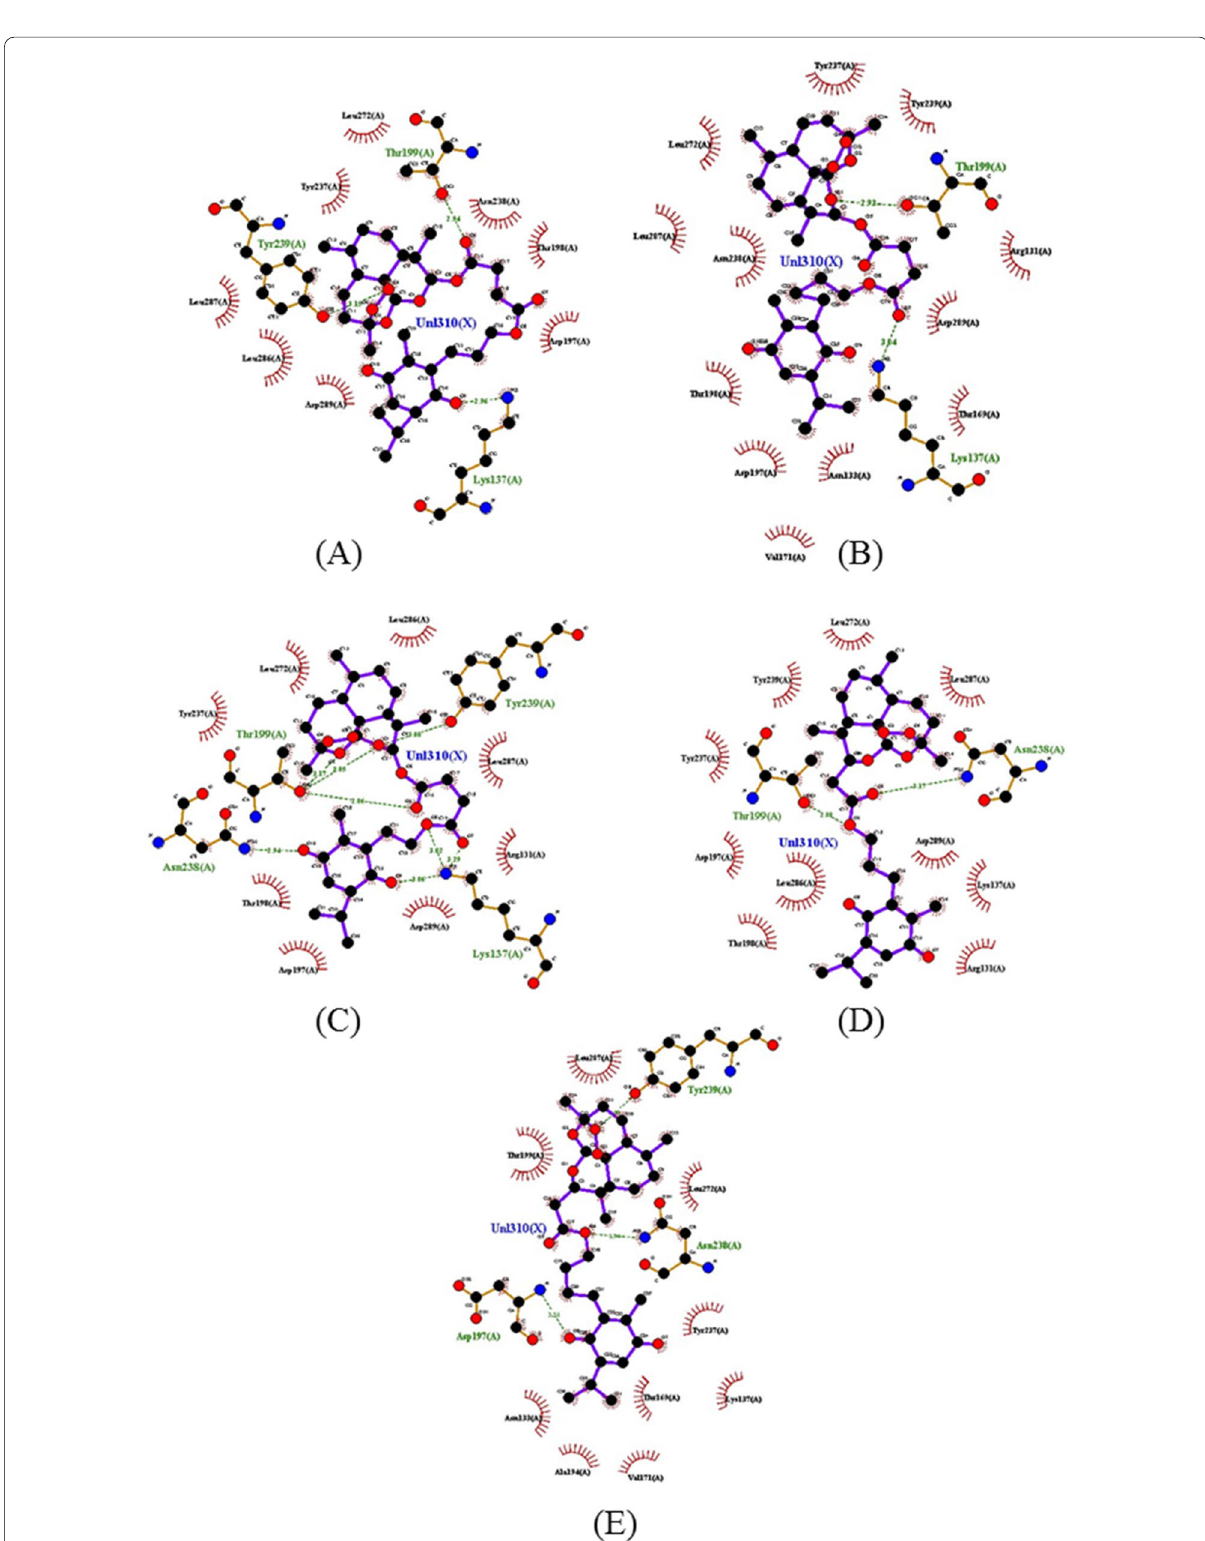
Fig. 7 2D map representative of H-bonds between ART-THY hybrids. A T1, B T2, C T3, D T4 e E